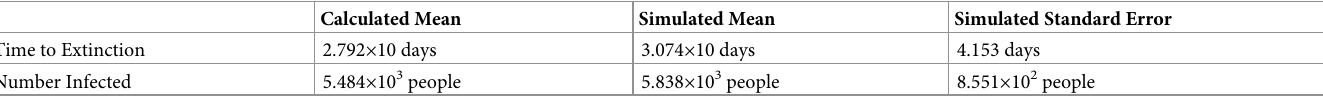
Table 1. Comparison between the calculated and simulated means of SIR model outcomes in the stochastic SIR model simulated under the initial conditions S 0 = 3.4 × 10 4 , I 0 = 1 and parameter values η = 0.7194, δ = .5025. Results for the simulated means were obtained using the BioSimulator package in Julia and averaging results over r = 100